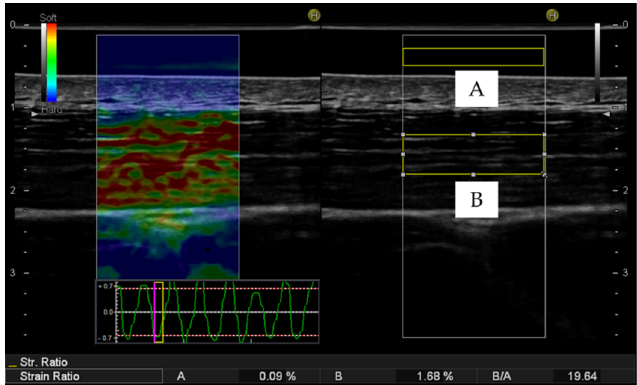
Figure 2. Example of strain elastography image and strain ratio. The region of interest (ROI) was set for the acoustic coupler ( A ) and on an area of the trapezius muscle ( B ). Strain ratio was defined as B/A. In the strain elastography image, the red color represents a soft area; blue, hard area; and green, an area in between soft and hard. The strain graph depicts the average tissue strains in response to pressure force.